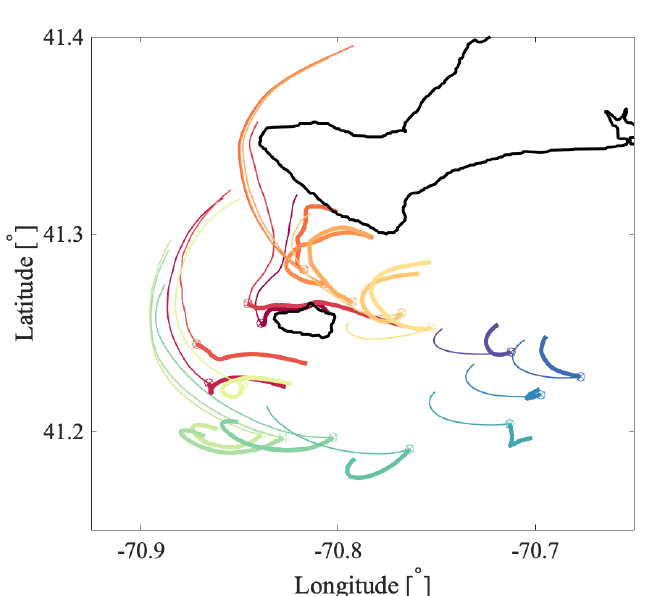
Figure A11. Comparison between real and simulated drifter trajectories for the 2018 No Man’s Land experiment between 16:00 and 22:00 UTC. The trajectories of CODE drifters are plotted with thick lines. The corresponding numerical trajectories, simulated with the same initial conditions as their corresponding CODE drifter, are plotted with thin